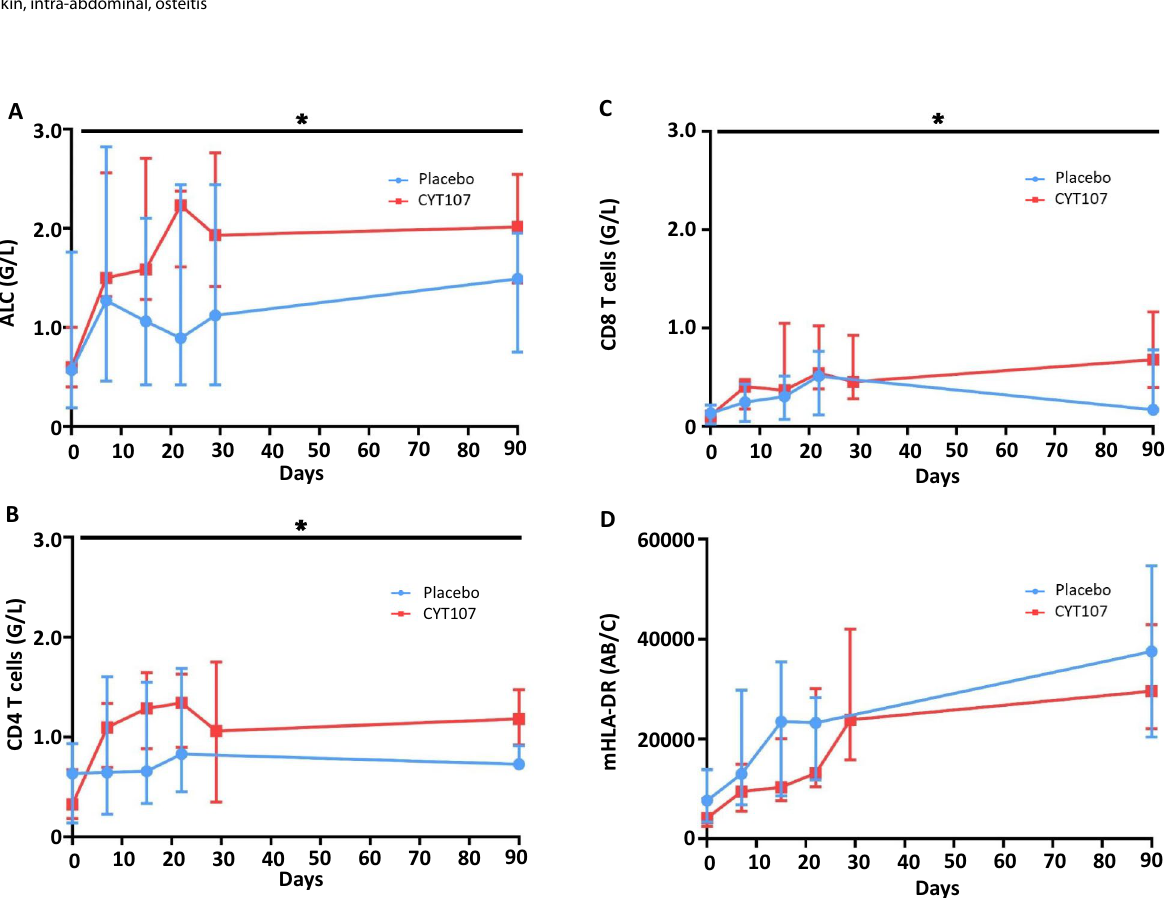
Fig. 1 CYT107 increases absolute lymphocyte counts and both CD4 + and CD8 + T lymphocytes . Patients’ peripheral blood was analyzed at day 0, 7, 15, 22, 29 (or hospital discharge) and day 90. Data are represented in median and interquartile. Patients who received CYT107 are represented in red. Patients who received placebo are represented in blue. A Median absolute lymphocyte counts : The absolute lymphocyte counts were higher in patients treated with CYT107 versus placebo; * p 0.005. B and C represents the median CD4 + and CD8 + T cells count for each group, respectively, = as obtained by flow cytometry. Both CD4 + and CD8 + T cell counts were significantly higher in the CYT107‑ versus placebo‑treated group after day seven, *( p < 0.005). D HLA‑DR expression on CD14 + monocytes was measured by flow cytometry and was indicated in median number of antibodies bound per cell